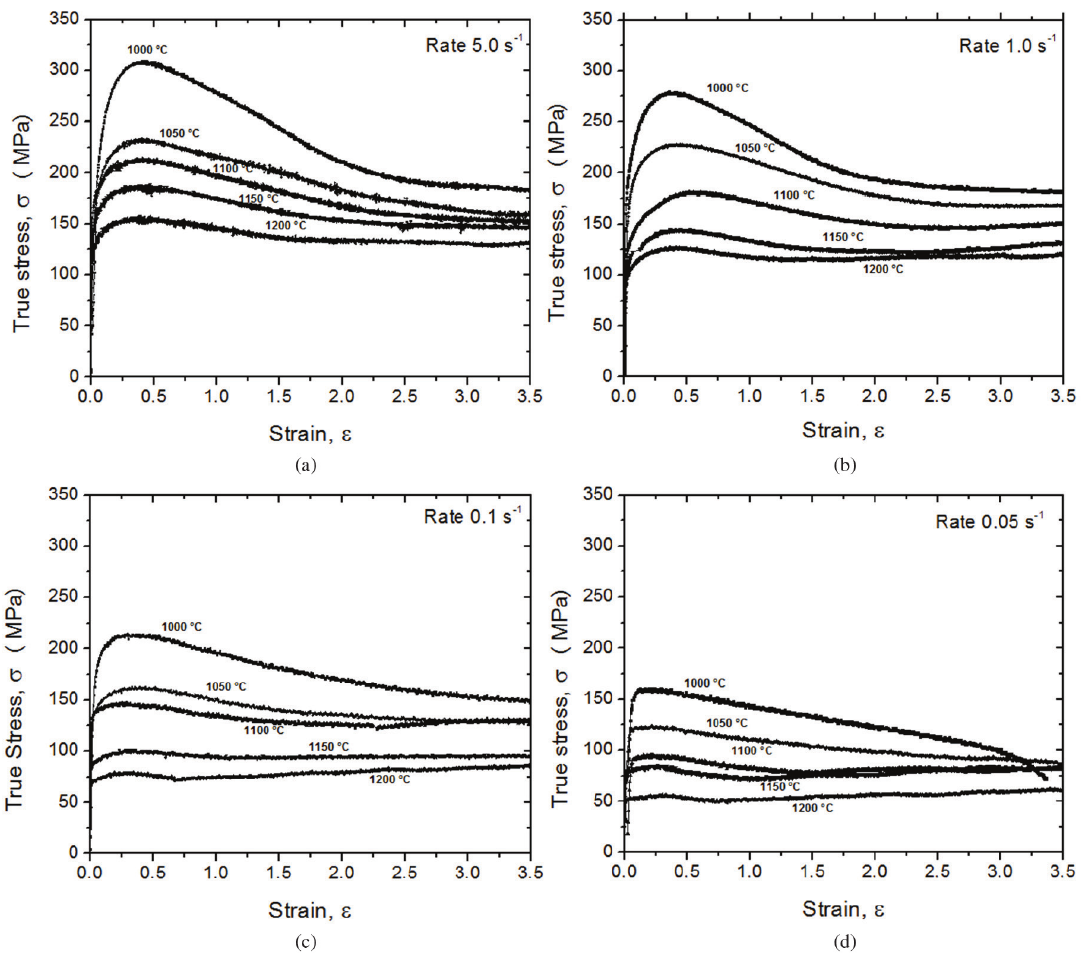
Figure 1. Plastic flow curves obtained from isothermal continuous torsion tests to different strain rate and temperatures: (a) 5.0 s –1 , (b) 1.0 s –1 , (c) 0.1 s –1 , (d) 0.05 s –1